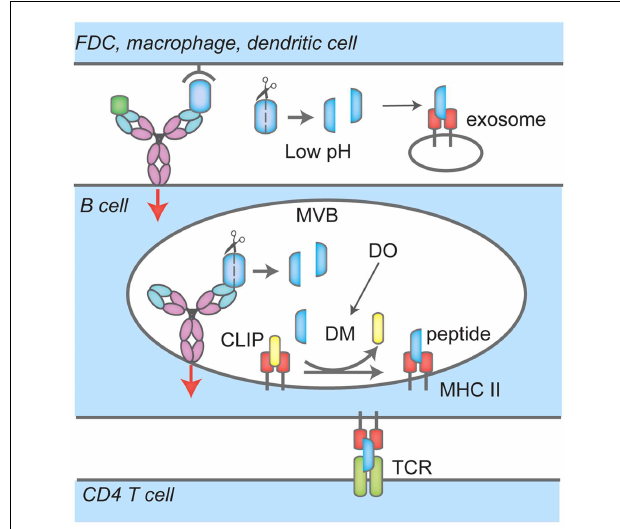
FIGURE 2 | Events that lead to antigen uptake by the BCR, loading onto MHC Class II and presentation to CD4T cells . BCR interacts with soluble antigen, or antigen presented by follicular dendritic cells (FDC), macrophages or dendritic cells at the immunological synapse (IS), leading to signaling events (red arrow), antigen-BCR complex uptake and translocation to multi-vesicular bodies (MVB).There, proteases cleave antigen into peptides that are loaded onto MHC Class II; H2/HLA-DM (DM) mediates the removal of the class II-associated peptide (CLIP) which prevents MHC Class II premature loading. H2/HLA-DO (DO) regulates DM. In these compartments, BCR signaling continues (red arrow). B cells also recruit and secrete MHC II-lysosomes to the IS space in a polarized fashion, lowering the pH and facilitating removal of antigen or proteolysis. Peptide-MHC II complexes are then transported to the cell surface for presentation to CD4T